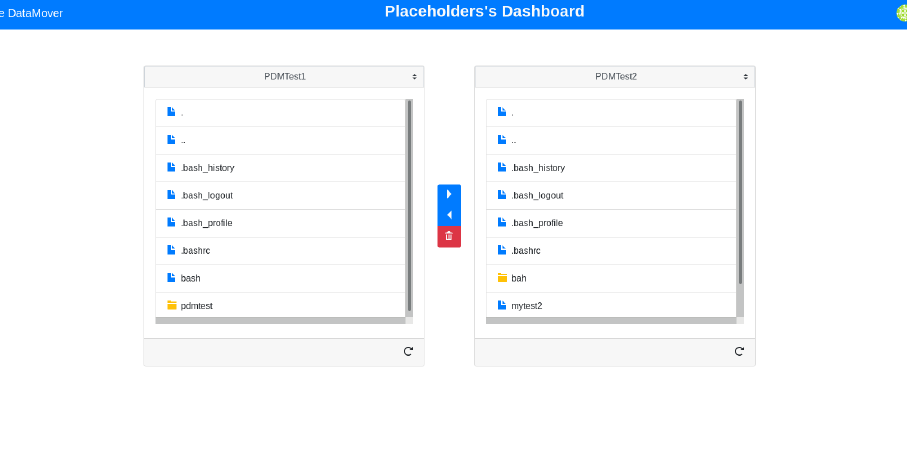
Figure 1. A schematic of the data transfer system.